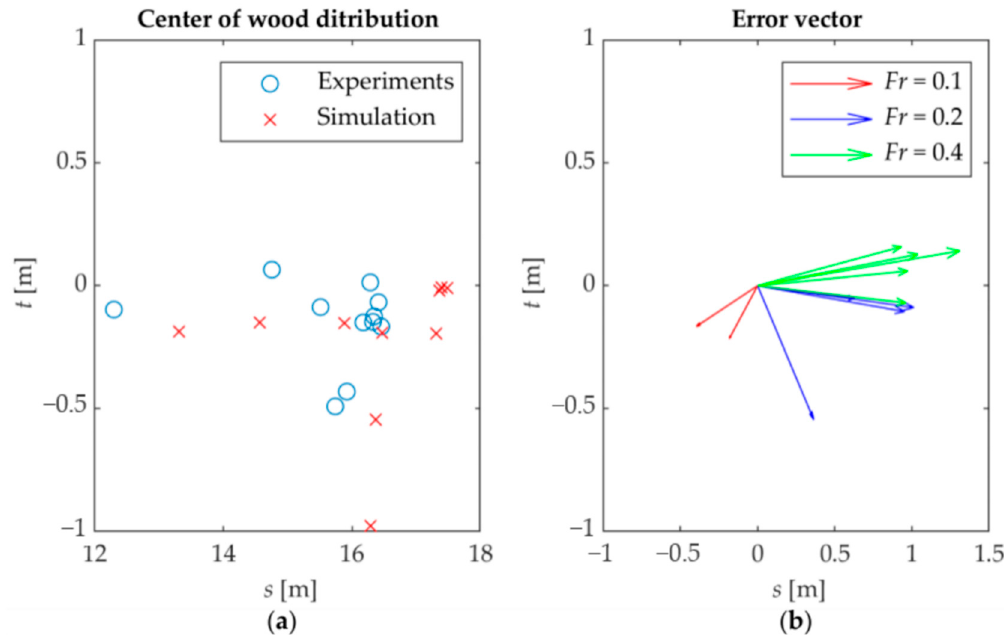
Figure 9. S-shaped flume. ( a ) Experimental mean coordinates and numerical most probable coordinates. ( b ) Difference vector between experimental and numerical coordinates.